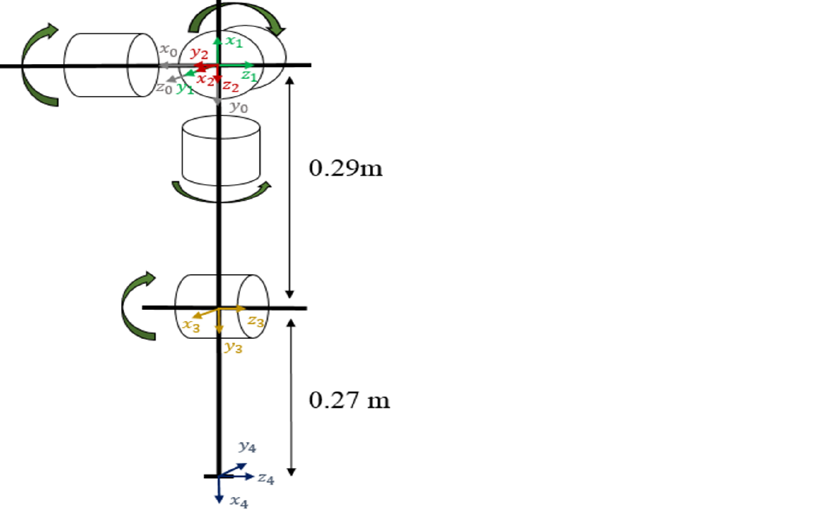
Figure 4. Schematic diagram of the relationship of the robotic arm coordinate system.